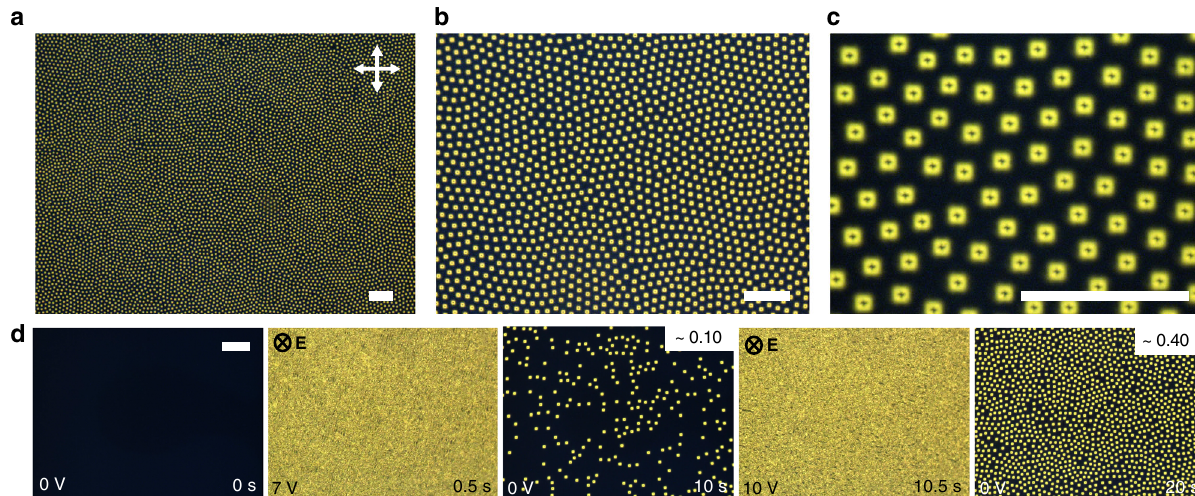
Fig. 9 Generation of skyrmions by relaxing electrohydrodynamic instabilities. a – c Polarizing micrographs (at different magni fi cations) of a dense skyrmion array created by relaxing the electrohydrodynamic instability. The scale bars are 100 µ m. d Polarizing micrographs showing the as-prepared sample initially without skyrmions at no applied fi elds (left image), electrohydrodynamic instability at U = 7 V (2nd image from the left), skyrmions at low number density forming upon switching back to U = 0 and relaxing the sample from electrohydrodynamic instability (3rd image from the left), electrohydrodynamic instability in the same sample area upon again applying U = 10 V (4th image from the left), and, fi nally, skyrmions at high number density forming upon switching back to U = 0 again and allowing the instability to relax (5th image from the left). These images illustrate the control of the initial skyrmion packing fraction (by area, displayed in the top-right of the images), where the amplitude of U used to generate electrohydrodynamic instabilities corelates with the ensuing skyrmion number densities. White double arrows denote crossed polarizer orientations. Elapsed time, skyrmion packing fraction by area, applied voltage, and direction of E are marked in the corners of micrographs. The used electric fi eld frequency was 10